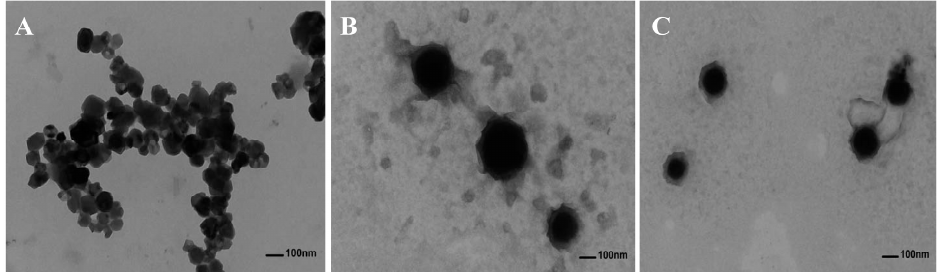
Figure 5. Transmission electron microscopy images of nanoparticles. ( A ) CSNPs; ( B ) RL-CSNPs; ( C ) XJ4-CSNPs.